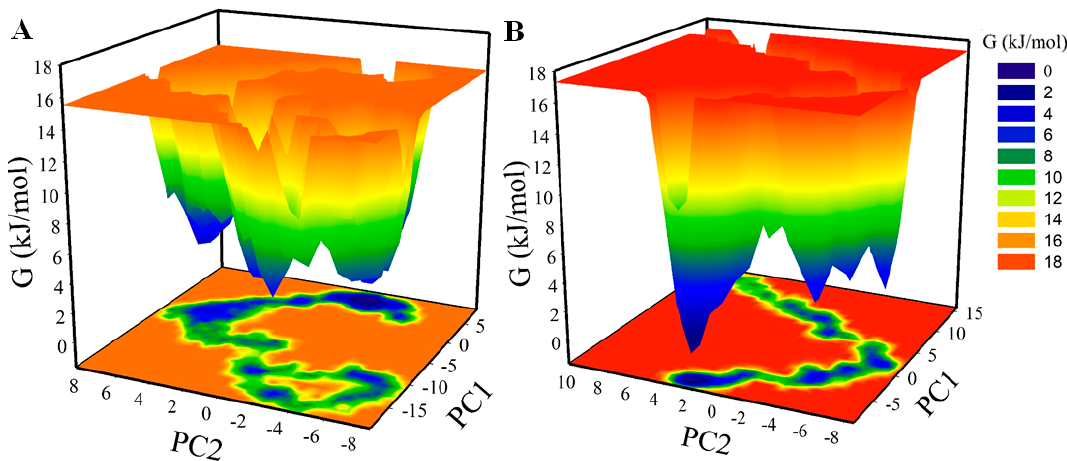
Figure 9. The Gibbs energy landscape obtained during 100 ns MD simulation for ( A ) free SGK1 and ( B ) SGK1-ZINC00319000 complex.